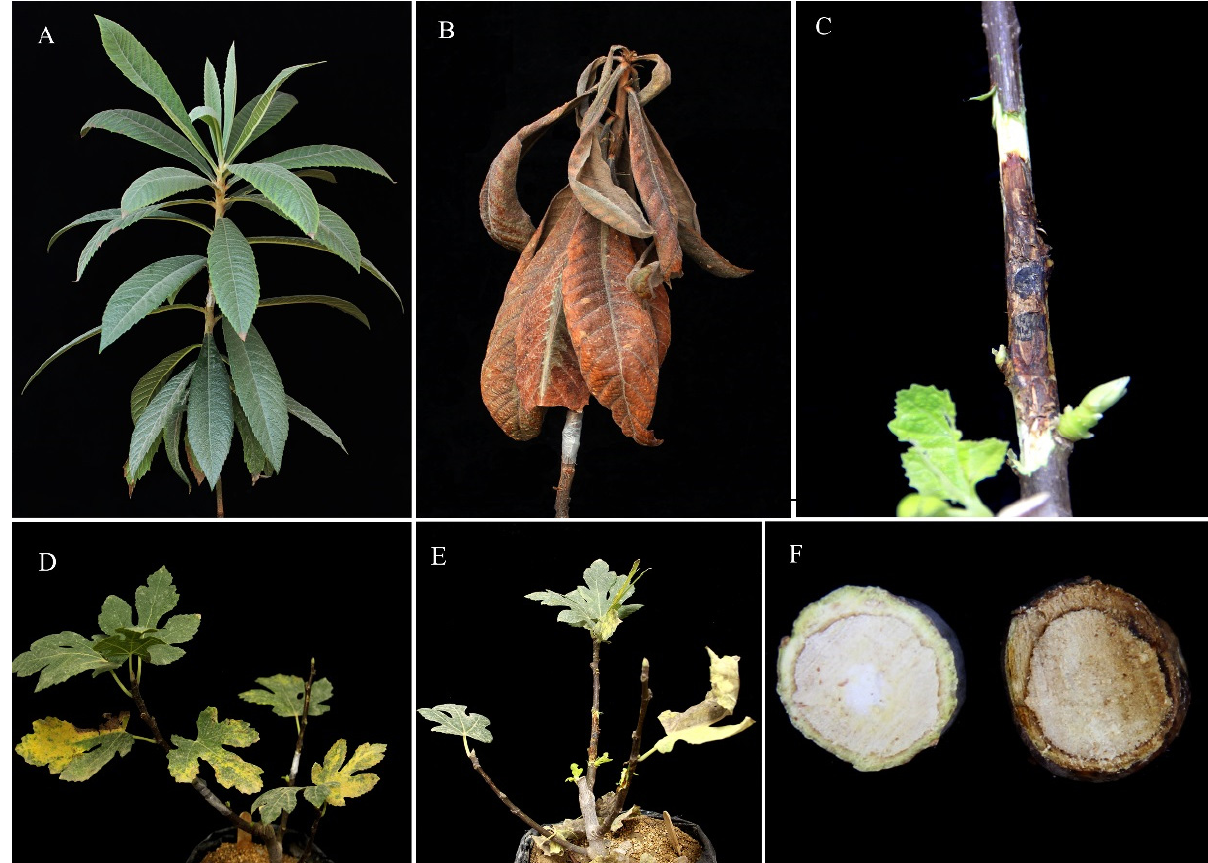
Figure 7. External and internal symptoms caused by Stilbocrea banihashemiana sp. nov. on artificially inoculated one-year-old saplings of fig and loquat. ( A ): Healthy loquat sapling (control)? ( B ): Wilting and dieback symptoms were observed 30 days after inoculation on a one-year-old loquat sapling. ( C ): Typical canker, discoloration, and necrotic lesion on a fig sapling. ( D , E ): External symptoms, including leaf yellowing ( D ) and defoliation ( E ), on a fig sapling 30 days after artificial inoculation. ( F ): Transerve section of a fig stem with symptoms of